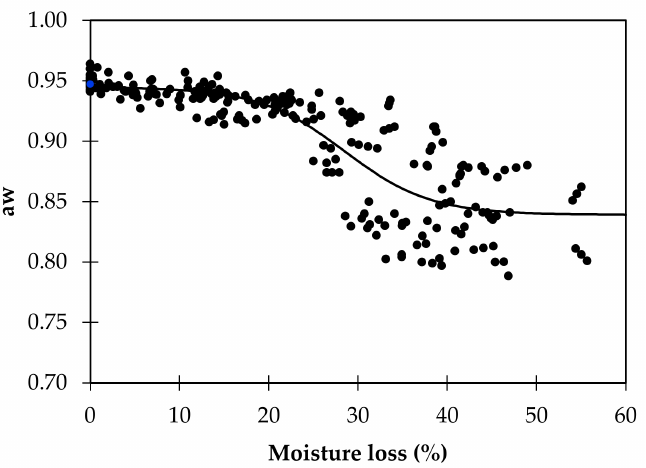
Figure 3. Nonlinear regression between aw and moisture loss for all the formulations ( n = 240). Table 3. Parameters of the nonlinear regression for each formulation and for the total data.